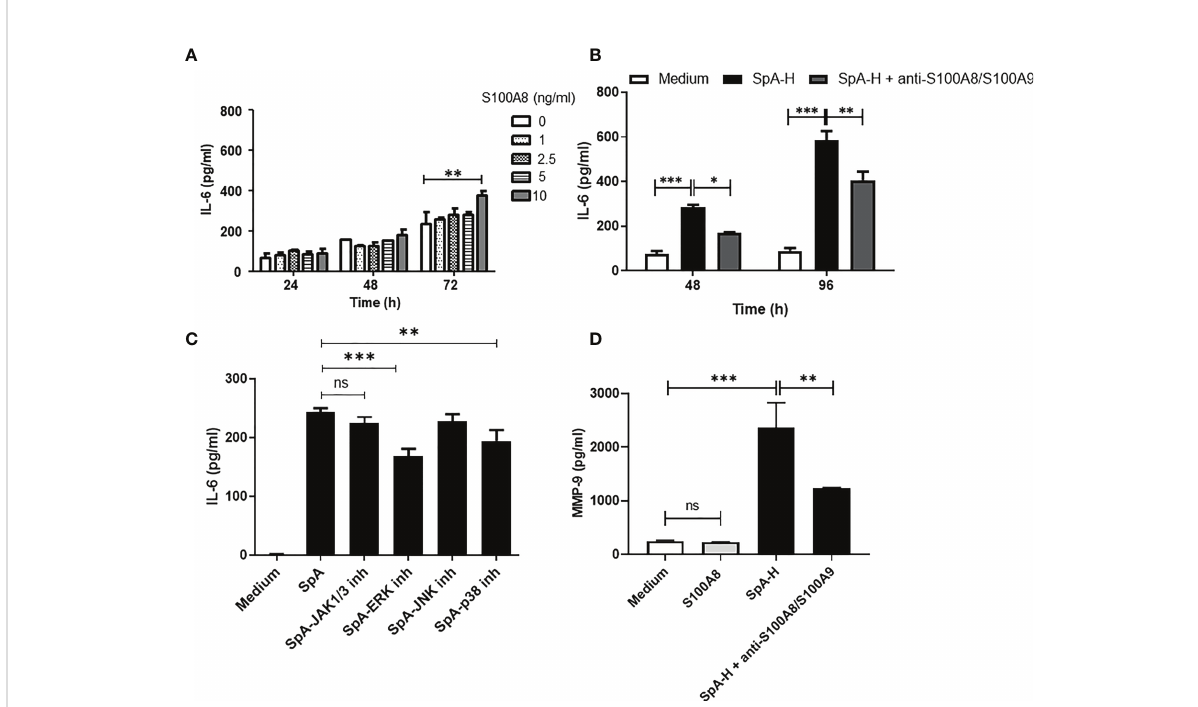
FIGURE 5 Synovial S100A8 induces IL-6 and MMP-9 secretion by FLS. (A) IL-6 levels secreted by SW982 FLS stimulated with S100A8 (1-10 ng/ml) or (B) with SpA SF pre-treated with hyaluronidase in the absence or presence of anti-S100A8/S100A9 antibody (5 m g/ml). In (C) , SW982 FLS were pre-treated with JAK1/3 or MAPKs inhibitors. (D) MMP-9 protein levels secreted by SW982 FLS stimulated with S100A8 (10 ng/ml) or SpA-H in the absence or presence of anti-S100A8/S100A9 antibody. Data of at least two independent experiments are shown. Values are presented as the mean ± SEM. *: p<0.05; **: p<0.01, ***: p<0.001, ns: non-signi fi